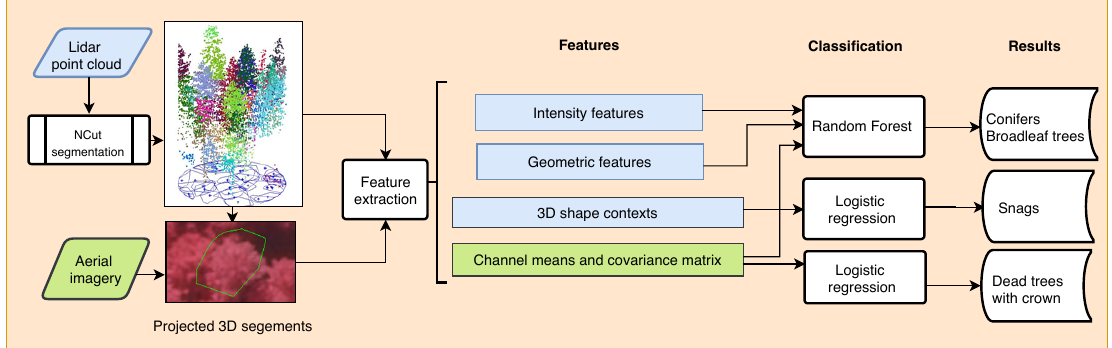
Figure 4. Overview of the approach for classification of conifers, broadleaf trees, standing dead trees, and